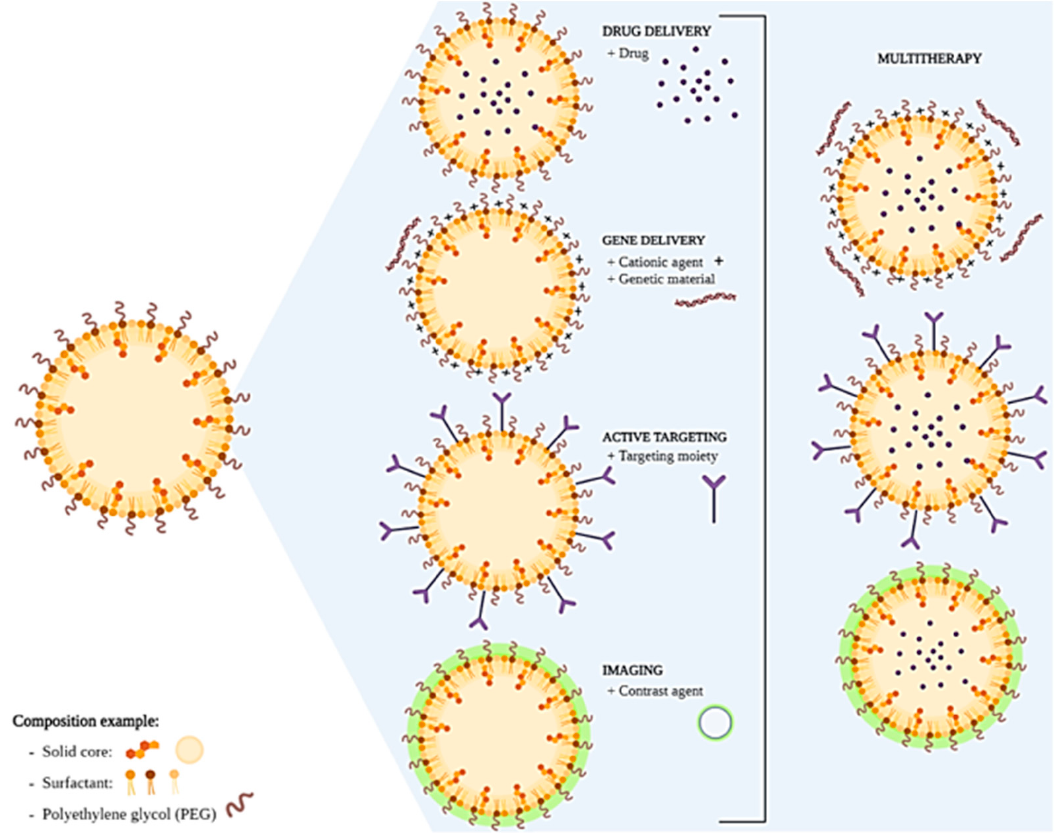
Figure 1. Schematic representation of SLNs development and final applications. Created in BioRender.com, accessed on 24 February 2023.